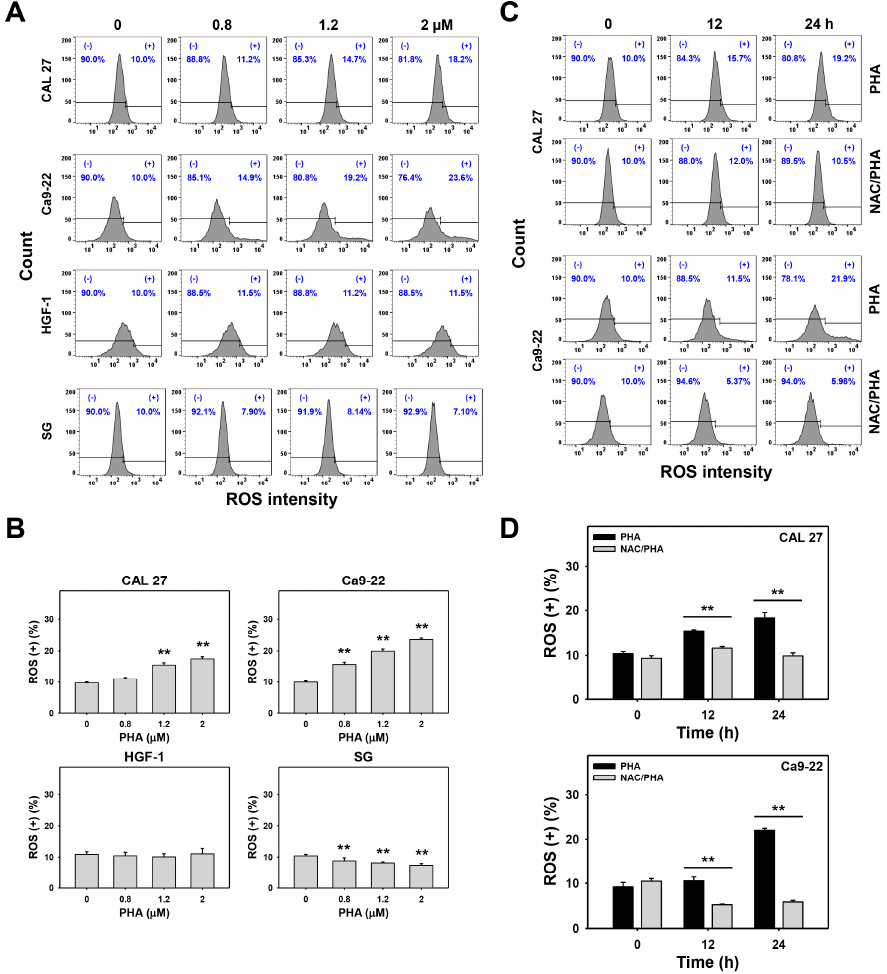
Figure 5. PHA enhances ROS intensity in oral cancer cells. ( A , B ) ROS analysis. Oral cancer (CAL 27 and Ca9-22) and non-malignant oral (HGF-1 and SG) cells were exposed to 0 (0.1% DMSO medium as control), 0.8, 1.2, and 2 μ M PHA for 24 h. (+) population was counted for ROS (+) (%). ( C , D ) Suppression of PHA-induced ROS by NAC. To evaluate the recovery effect of NAC, NAC (10 mM for 1 h) was added to cells before 12 and 24 h treatment with PHA (control (0.1% DMSO medium) and 2 μ M), i.e., NAC/PHA. Data, means ± SDs ( n = 3 independent experiments); ** indicates p < 0.001.